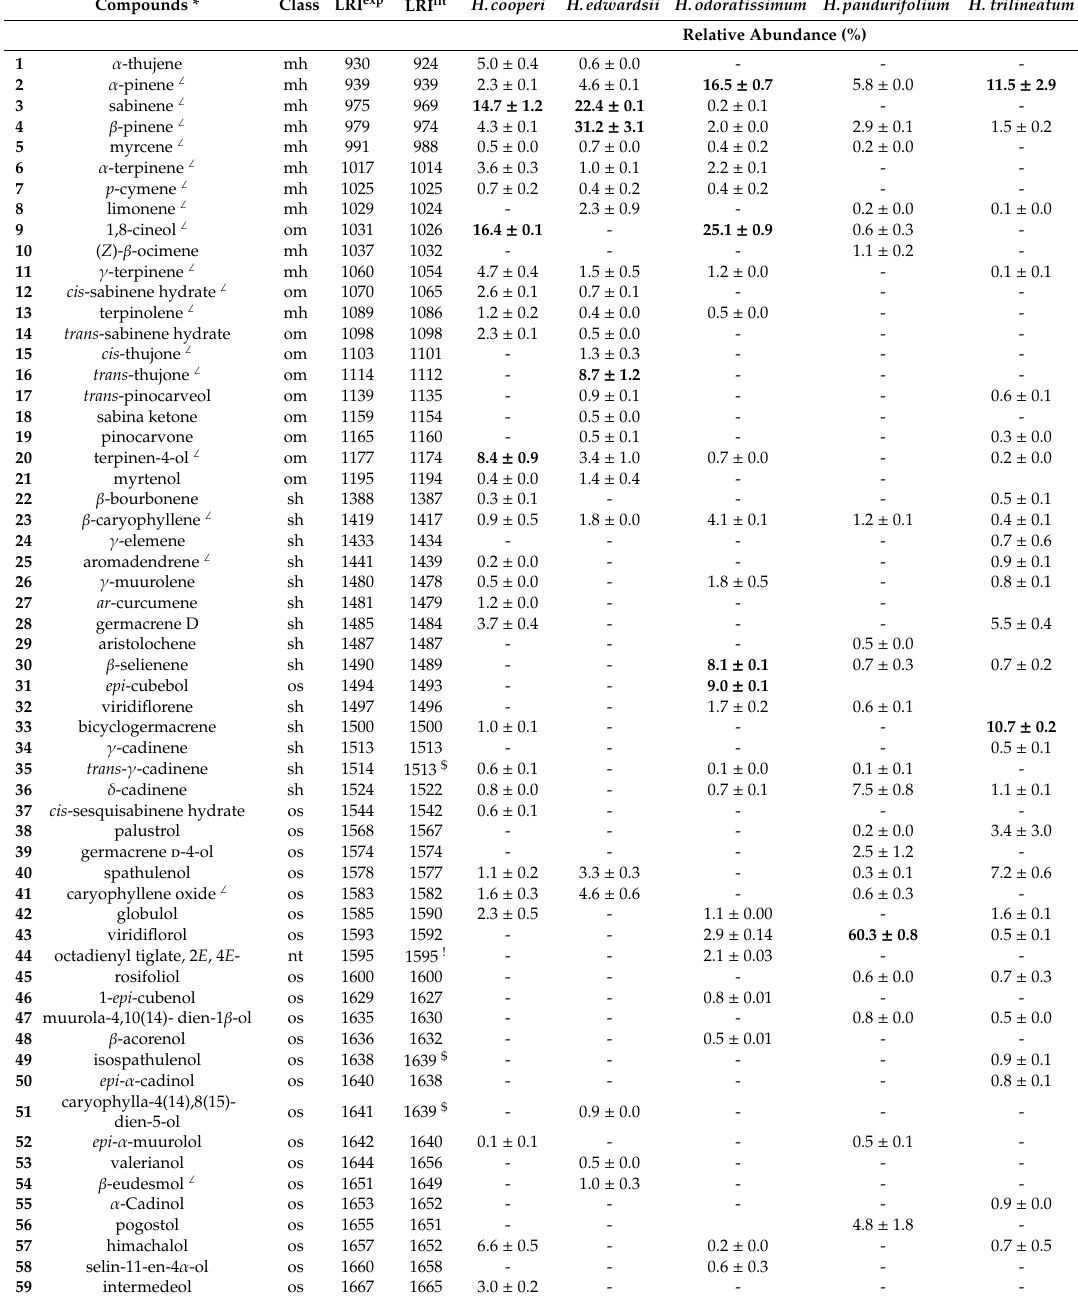
Table 3. Identified compounds in the essential oils of the studied Helichysum spp. (for chromatograms, see Table S2 in Supplementary